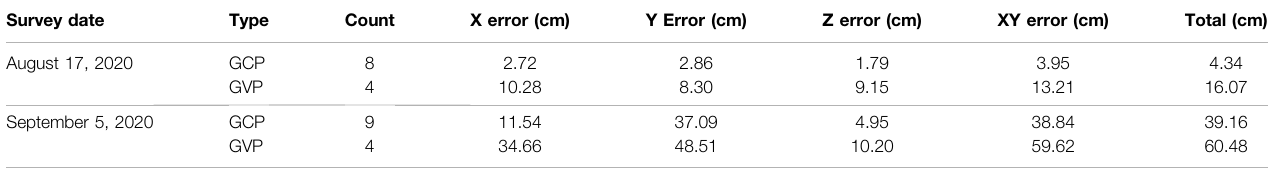
TABLE1| ControlpointerrorswhereXrepresentsLongitude,YrepresentsLatitude,andZrepresentsAltitude.Groundcontrolpoints(GCPs)wereusedinthealigningofthe orthomosaic while the ground validation points (GVPs) were omitted and used to assess the reconstruction accuracy.